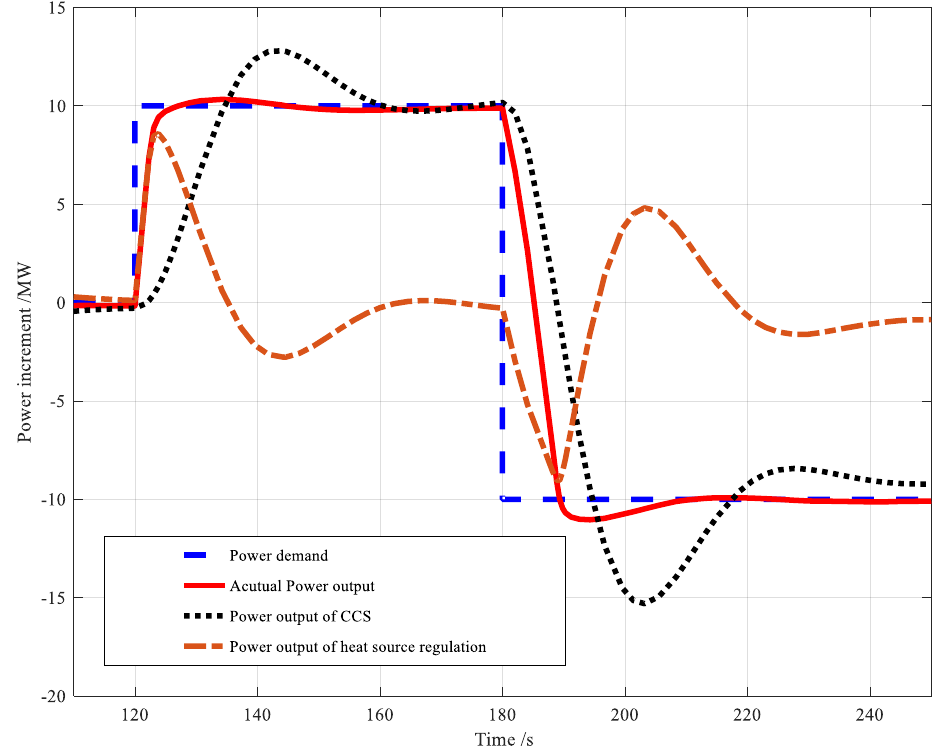
Figure 8. Power responses of CCS and heat source regulation with our optimized control strategy.